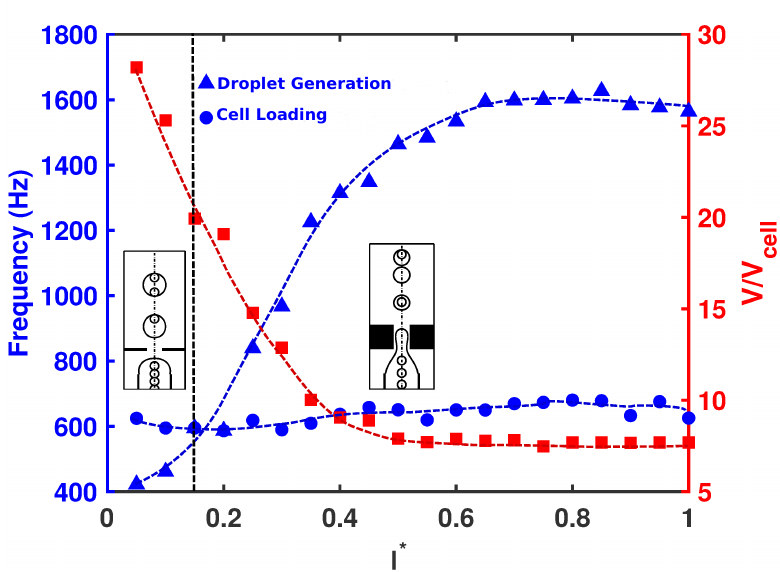
Figure 5. Frequency of droplet generation (triangles) versus frequency of cell loading (circles) and non-dimensional droplet size (squares) for configurations with different non-dimensional orifice lengths at Ca i = Ca o = 10 − 3 . Other geometrical parameters are kept fixed ( r ∗ = 0.25 and d ∗ =